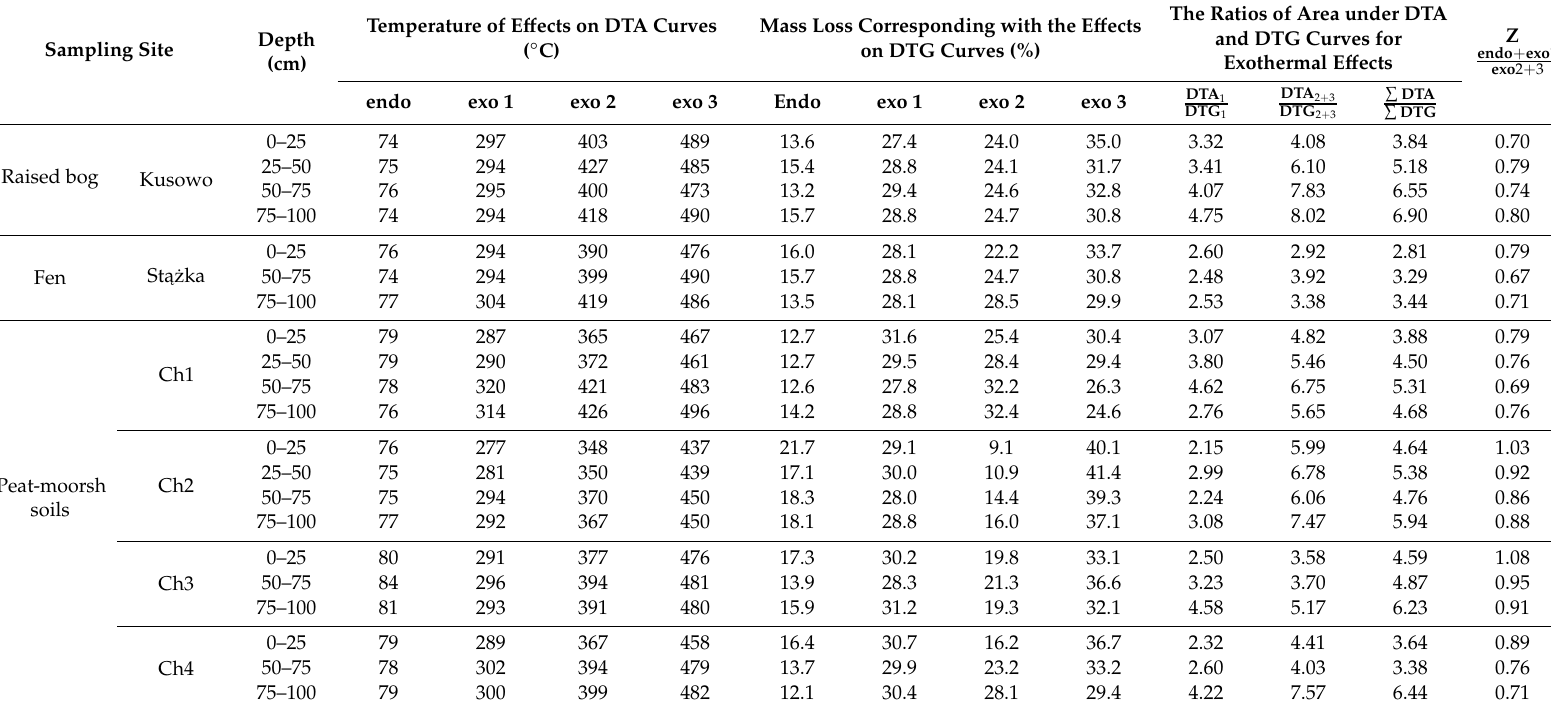
Table 8. Parameters of thermal decomposition of